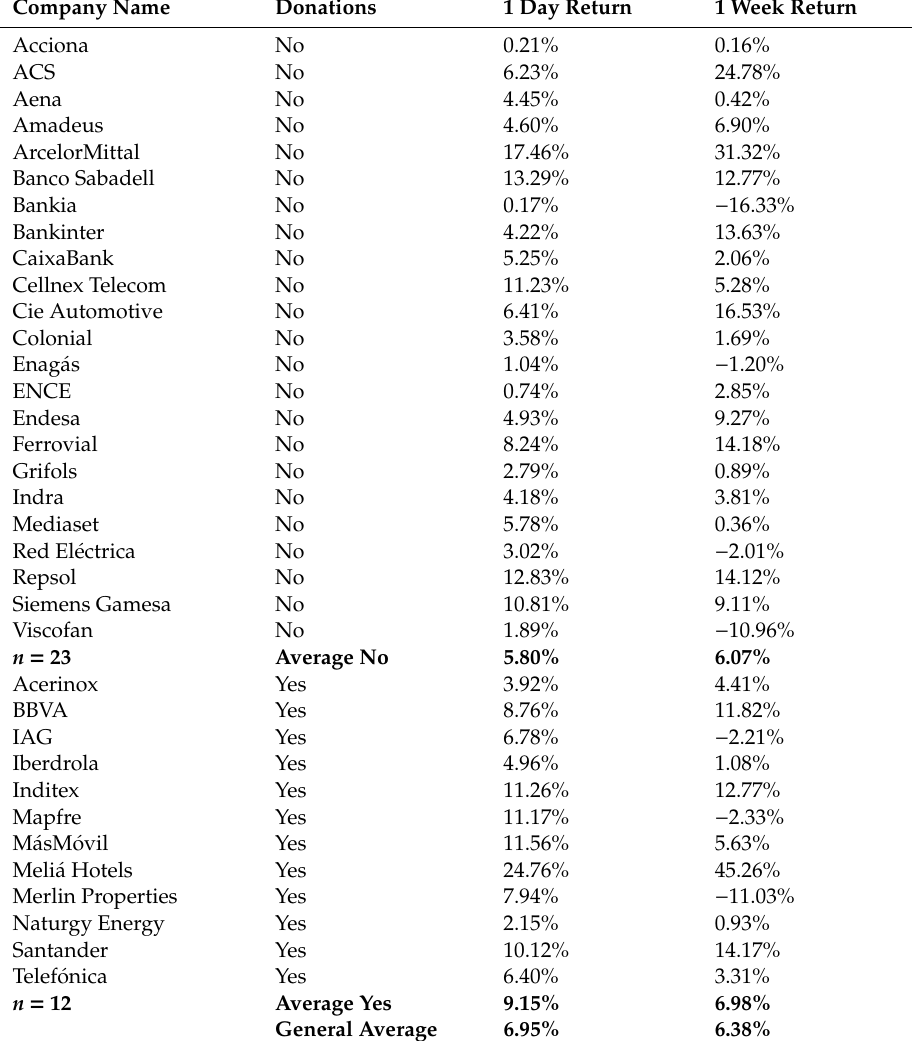
Table 1. Average return of IBEX-35